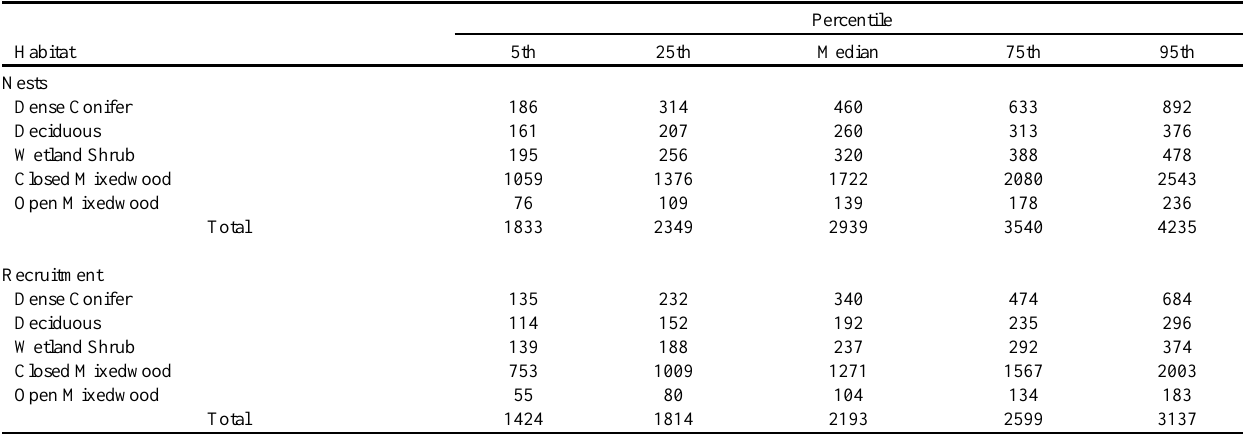
Table 5 . Estimated annual nests and recruitment into year lost because of oil sands mining operations in the Athabasca oil t+1 sands region. Estimates were generated based upon Monte Carlo simulations using a model combining estimated areas disturbed, estimated nesting densities and demographic parameters from the literature (see Methods). Percentile Habitat 5th 25th Median 75th 95th Nests Dense Conifer 186 314